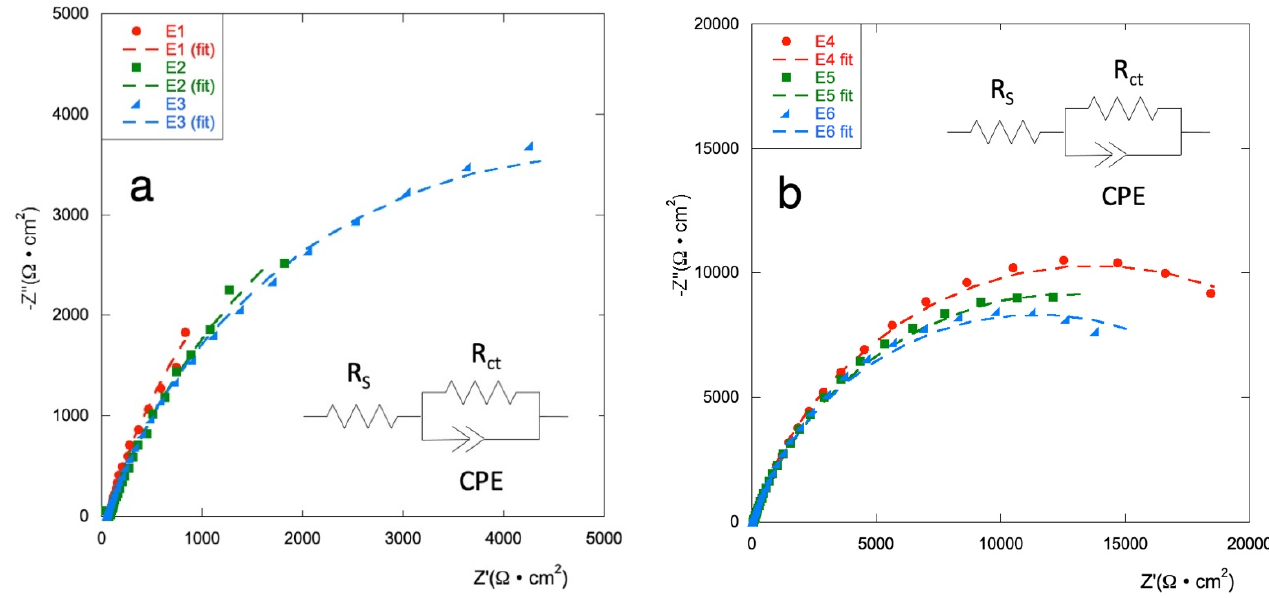
Figure 3. Nyquist diagrams (experimental data and fit) for ( a ) E1–E3 series and, ( b ) for E4–E6 series, in Na 2 SO 4 0.1 mol·L − 1 at potential E = 0 V vs. ref.